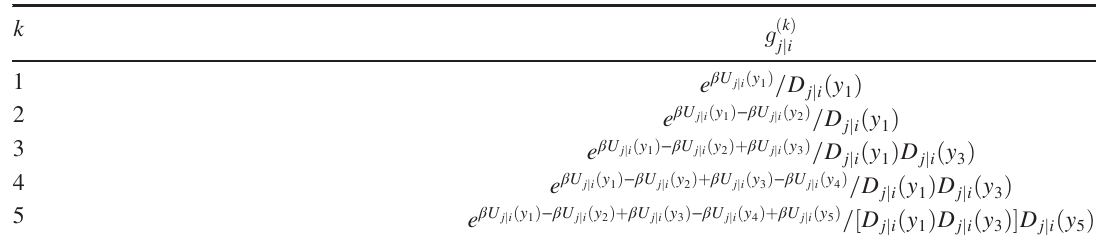
TABLE I. Integrands entering Eq. (9) at a glance.